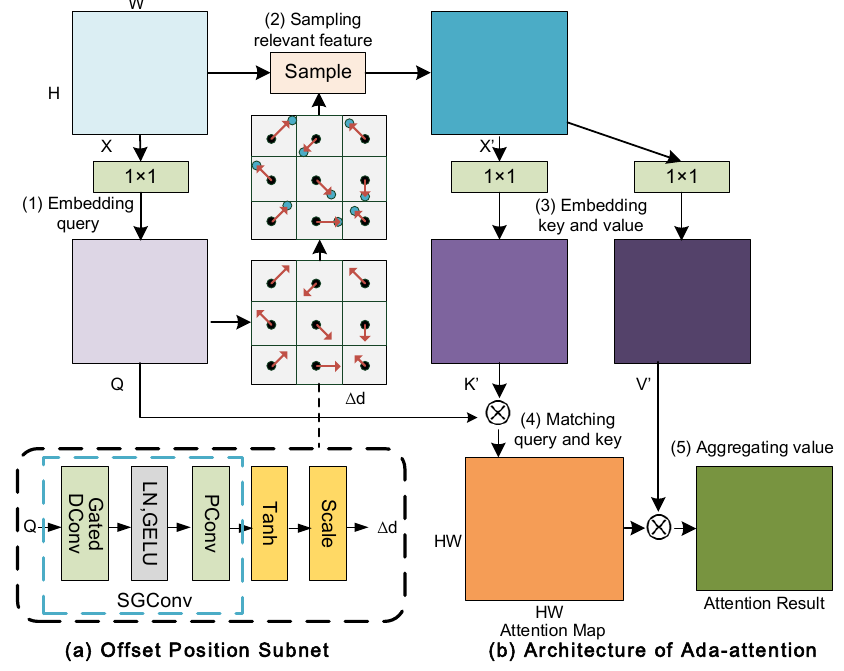
Figure 3. The architecture of the single head Ada-attention and offset position subnet. The Ada-attention contains five steps: embedding query, sampling relevant feature, embedding key and value, matching query and key, and aggregating value. The X ∈ R H × W × C is the input feature. H , W , and C are the height, width, and channel. X (cid:48) , Q , K (cid:48) , and V (cid:48) denote the sampling input feature, query, adjusted key, and adjusted value, respectively. (cid:52) d is the offset position. The dimension of the attention map is HW × HW . (cid:78) is the matrix